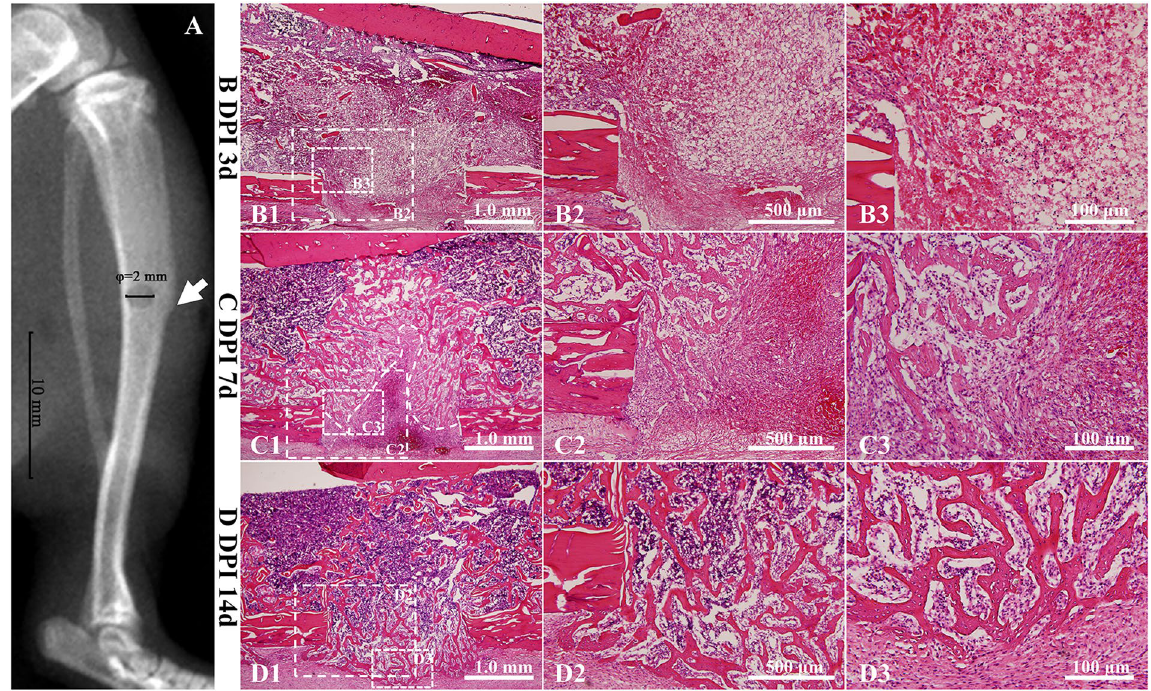
Figure 1. The drilling site of the tibia bone defect and the repair process at different time points. ( A ) X-ray of the tibia bone defect showing the drilling site. The white arrow was pointed to the tibial crest. The diameter of the hole is 2 mm. ( B – D ) H/E staining of the injured region at 3, 7 and 14 days post-injury. DPI: days post-injury. ( B ). The hematoma has been well organized at 3 days post-injury, with plenty of vascular tissues invading into and a large number of cells migrating into the inner. ( C ) As the dotted line showed, the frontier growth area could be identified at 7 days post-injury. The thickness of trabecular bones near the frontier growth area was relatively small compared with those away from the frontier growth area. Osteoblasts could be found at the surface of trabecular bones. Vascular structures existed both at the surface and periphery of trabecular bones. A large number of cells accumulated at the forward of frontier growth area and new trabecular bones was forming. ( D ) Newly formed trabecular bones have bridged the bilateral cortical bones at 14 days post-injury. At this time point, the repair period was in the process of bone remodeling stage. Bone marrow cavity has been gradually